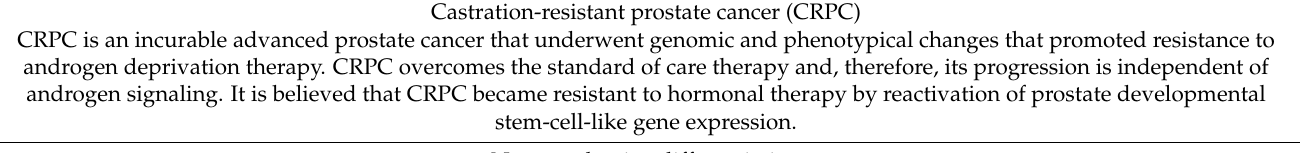
Table 1. Concept